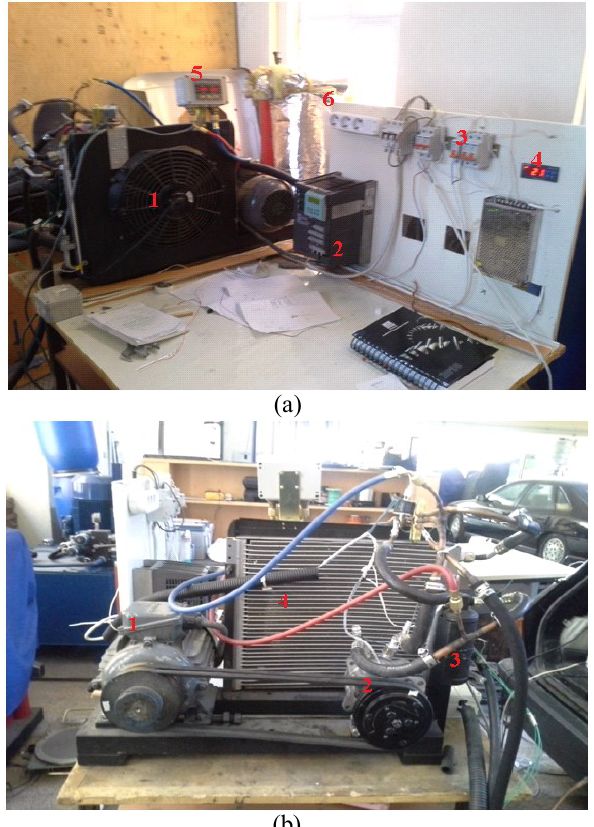
Fig. 3. Images of the air conditioner and its control panel (a) control side (b) operation